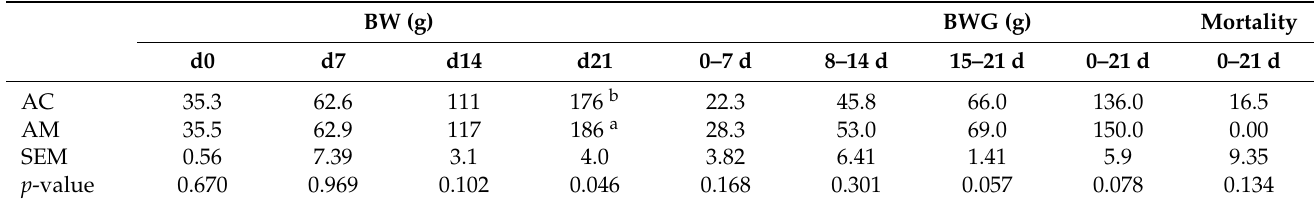
Table 7. Means of body weight ( BW ) at 0 ( BW0 ), 7 ( BW7 ), 14 ( BW14 ), and 21 ( BW21 ) days ( d ) posthatch; BW gain ( BWG ) between 0 and 7 ( BWG0-7 ), 7 and 14 ( BWG7-14 ), 14 and 21 ( BWG14-